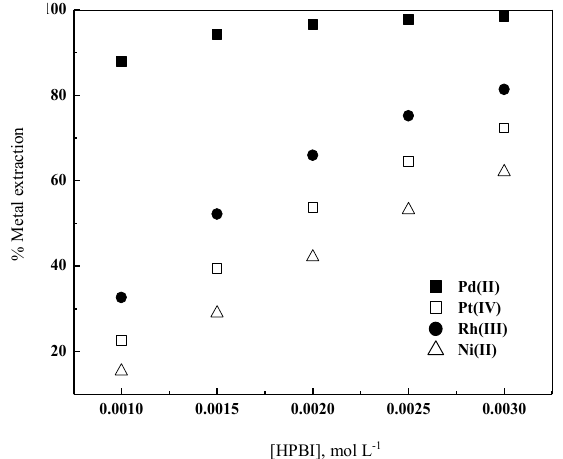
Figure 8. Separation studies of Pd(II) from acidic chloride solutions of Pt(IV), Ni(II) and Rh(III) as a function of the HPBI concentration. [M] = 1.12 × 10 -4 mol L -1 at 0.05 mol L -1 H + with 1.0 mol L -1 Cl -